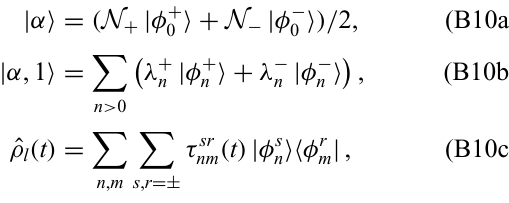
− e + | in units of n n